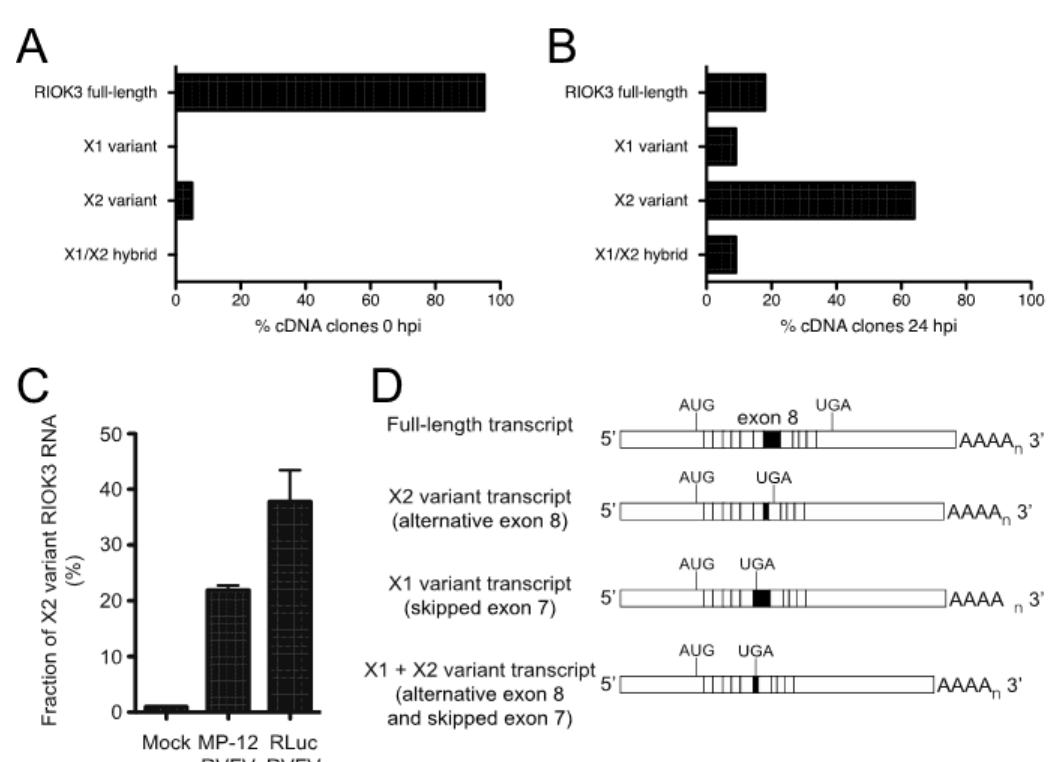
Figure 3. RVFV infection induces alternative splicing of RIOK3 transcripts. Distribution of RIOK3 splicing isoforms in either mock-infected ( A ) or rLuc RVFV infected ( B ) HEK293 cells. Total RNA was purified from mock- or virus-infected cells, reverse transcribed/PCR amplified into mRNA-length cDNAs, and cloned in a plasmid. From each sample, 40 individual clones were sequenced and categorized as full length, X1, X2, or X1/X2 hybrid. ( C ) Prevalence of RIOK3 X2 alternative splicing in infected cells. HEK293 cells were infected (MOI 1.0) with either MP-12 or rLuc RVFV and total RNA was extracted after 24 h. The fraction of X2 variant alternative splicing was quantified by RT-qPCR using primers specific to detect the canonical and X2 isoforms at exons 8 and 9, and not necessarily in full length poly-adenylylated mRNAs, which were characterized in panels ( A , B ). Data in panel C is presented as mean +/− SEM from triplicate experiments. ( D ) Schematic of the different splicing patterns observed. X2 employs a cryptic splice donor site within exon 8, resulting in a shortened exon 8 and a new stop codon in exon 9. X1 skips exon 7 entirely. Some transcripts contained both X1 and X2 type alternative splicing.